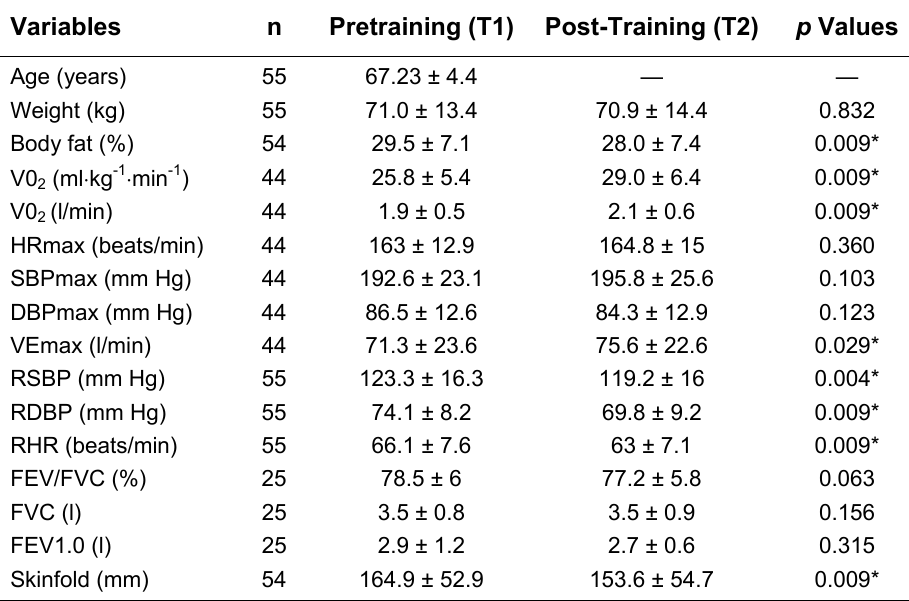
Pretraining and Post-Training